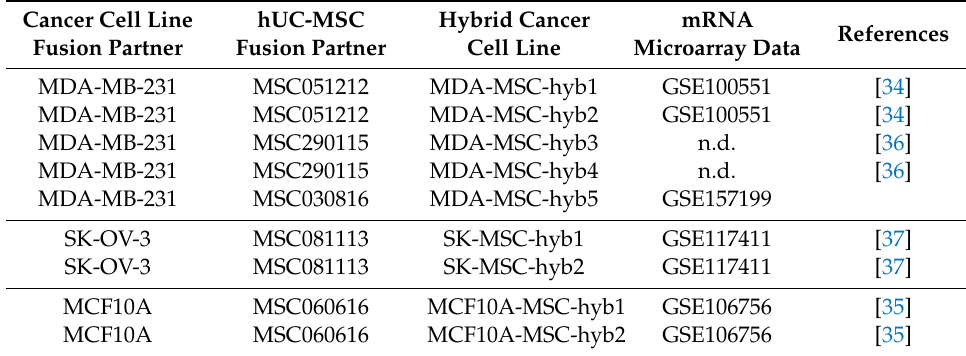
Table 1. Di ff erent hybrid cancer cell lines following spontaneous fusion with individual hUC-MSC. Cancer Cell